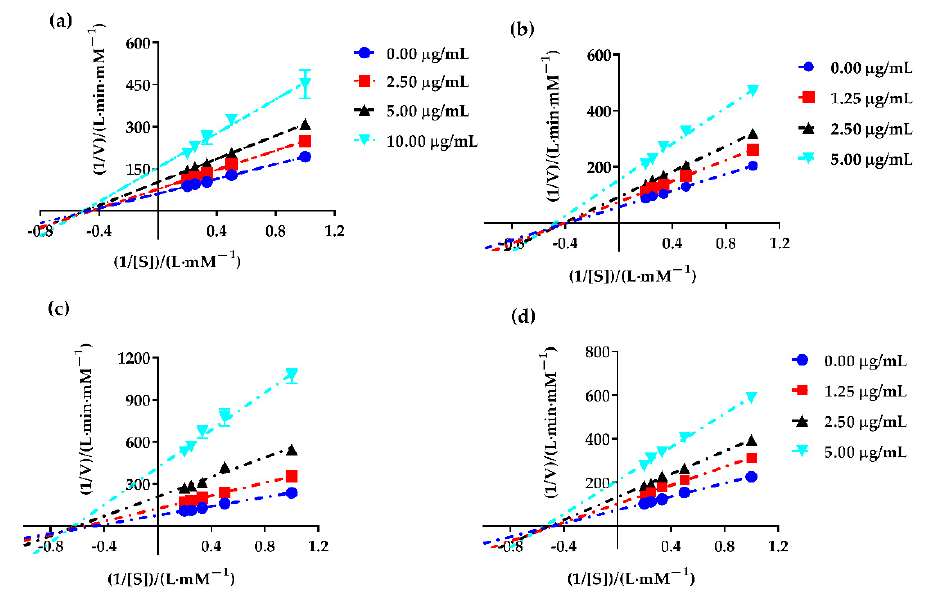
Figure 2. The Lineweaver–Burk plot of PAHEE and its fractions. ( a ) 1/[S]–1/V fitting curve of PAHEE. ( b ) 1/[S]–1/V fitting curve of PEF. ( c ) 1/[S]–1/V fitting curve of EAF. ( d ) 1/[S]–1/V fitting curve of NBF, and all values are mean ± SD from a least three independent experiments.